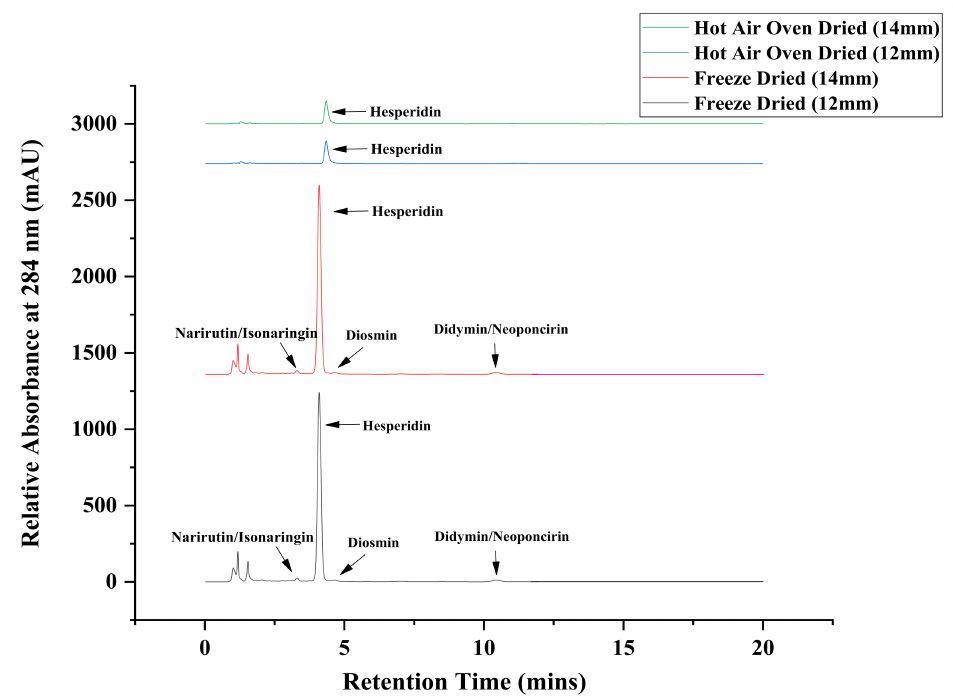
Figure 2. High-performance liquid chromatography (HPLC) chromatogram of flavonoids content of 12 mm and 14 mm physiologically dropped immature fruits after freeze drying and hot air oven